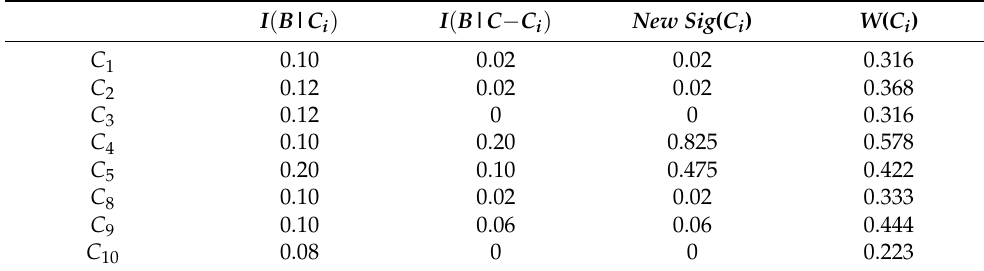
Table 6. Condition entropy, importance degree and attribute weight of index layer.